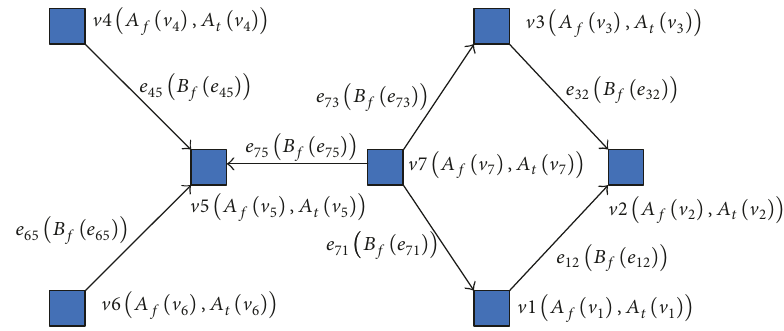
Figure 1: The holistic topological